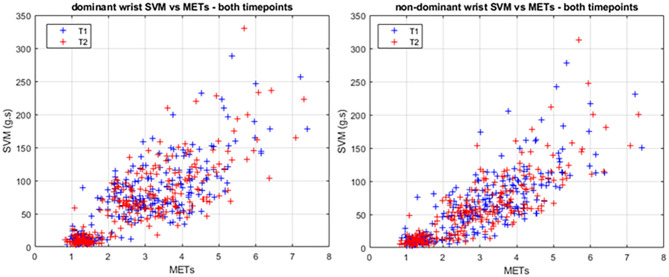
SVM vs. METs for the dominant (left) and non-dominant (right) wrists. Each point represents one activity and one participant. Timepoint 1 and 2 are shown in blue and red, respectively.